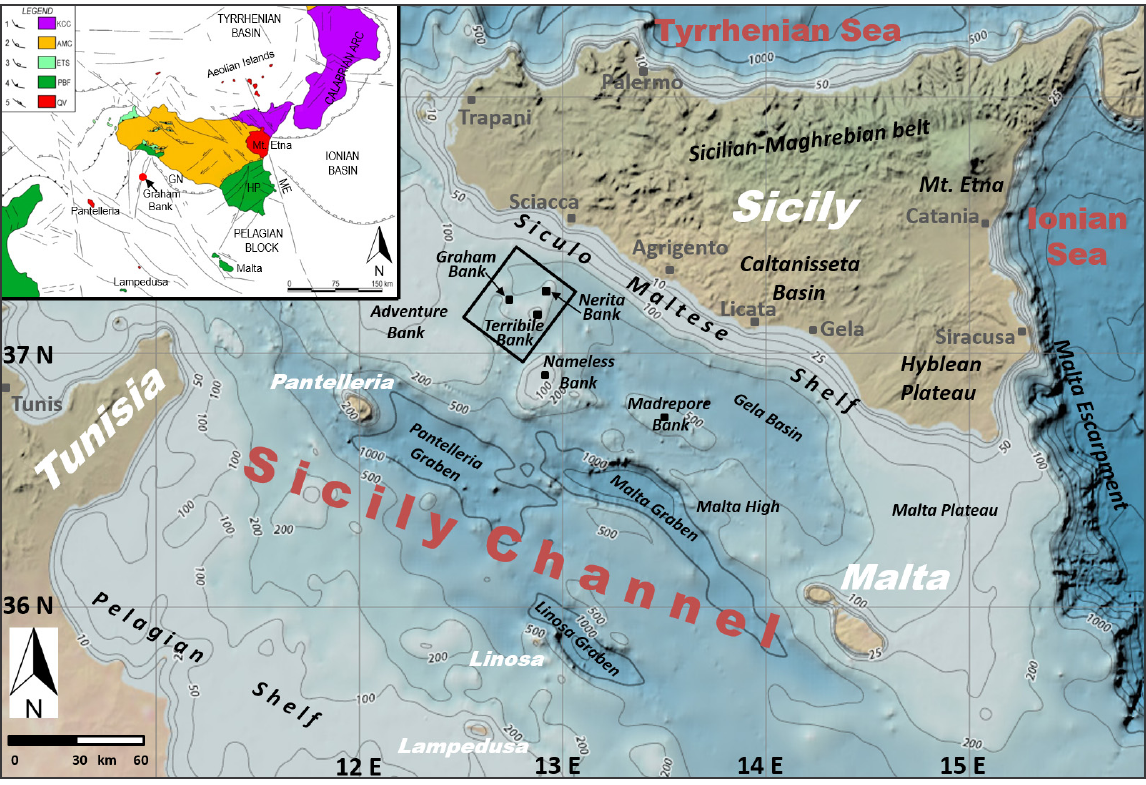
Figure 1. Bathymetric map of the Sicily Channel (bathymetry from Gebco - General bathymetric chart of the oceans). The black box dis- plays the study area. The inset shows the structural setting of central Mediterranean Sea (modified from Lentini et al. [2006]): (1) Overthrust of the Sardinian block upon Kabilo-Calabride (KCC) units; (2) Overthrust of the KCC units upon the Apennine-Maghrebian Chain (AMC); (3) External front of AMC upon the foreland units and the external thrust system (ETS); (4) Thrust front of ETS; (5) Main normal and strike- slip faults. PBF: Pelagian block foreland units; QV: Quaternary volcanoes; ME: Malta Escarpment; HP: Hyblean Plateau; GN: Gela